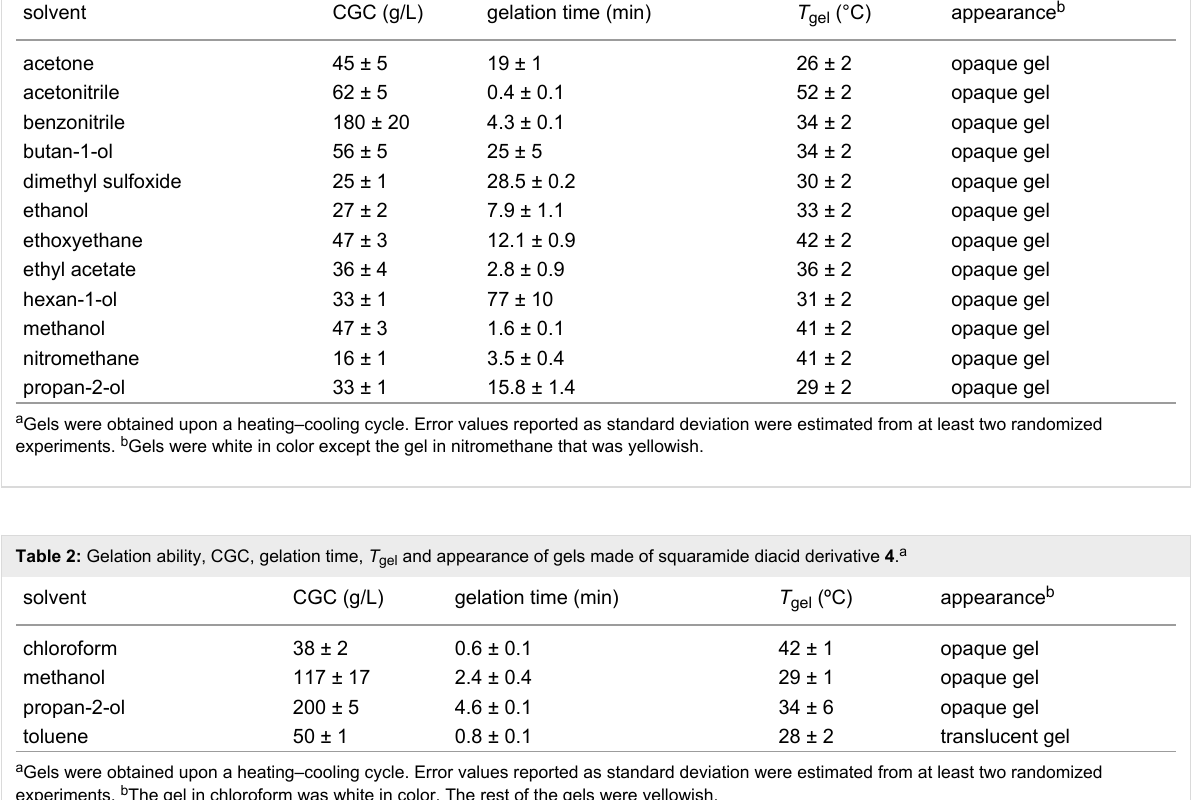
Table 1: Gelation ability, CGC, gelation time, T gel and appearance of gels made of squaramide diester derivative 3 . a solvent